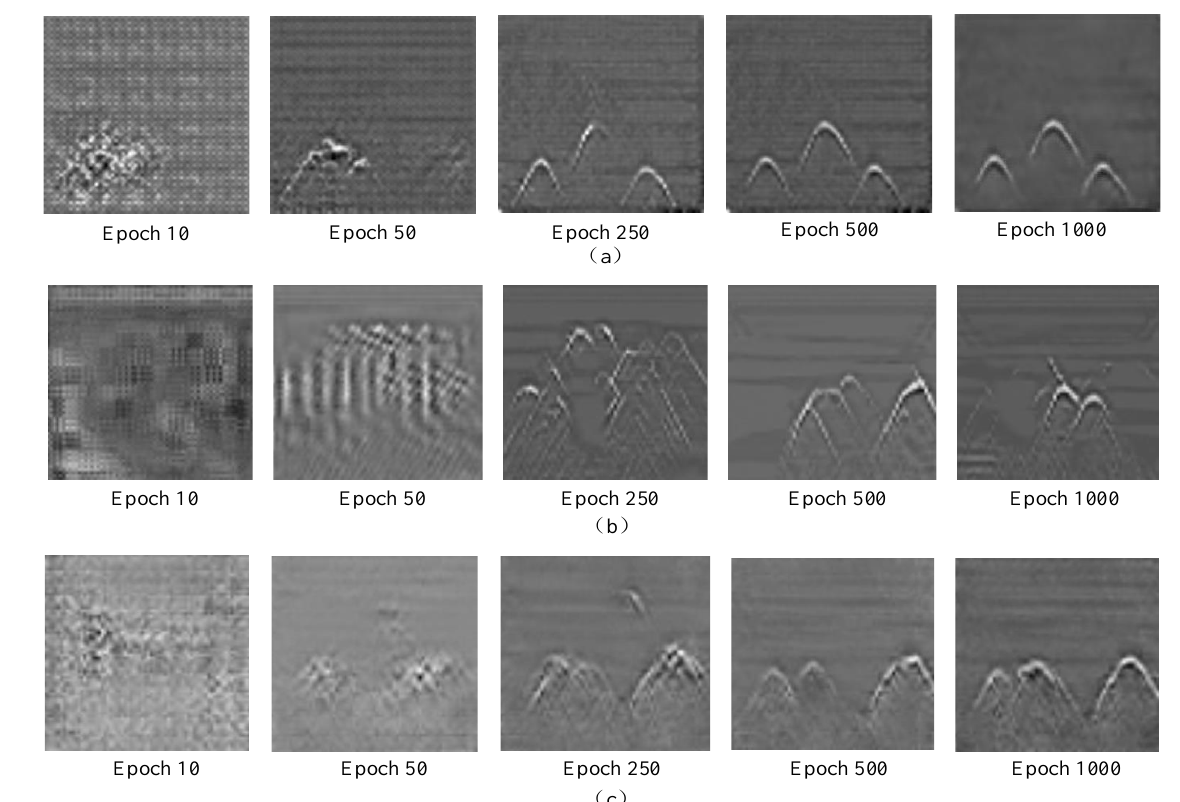
Figure 4. Generated GPR images using different GAN methods with respect to different training epochs: ( a ) WGAN; ( b ) DCGAN; ( c ) ACGAN.